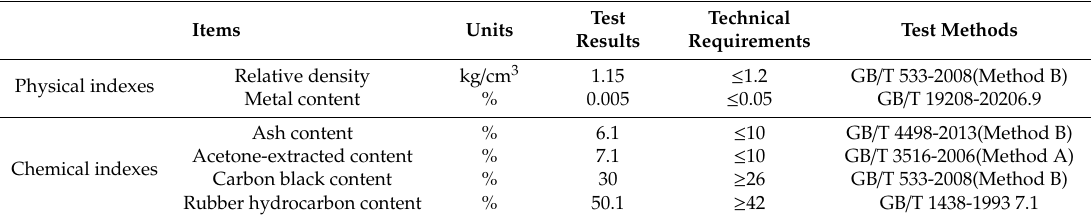
Table 3. Technical indexes of crumb rubber powder